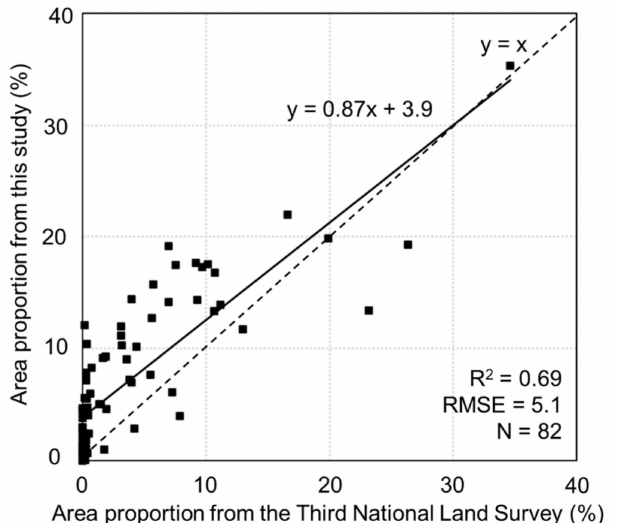
Figure 7. Comparison of bamboo area proportion (%) in this study and China’s Third National Land Survey. The linear fitted line and 1:1 line (y = x) are labelled in the figure by solid line and dashed line respectively. R 2 represents the correlation coefficient, and RMSE represents the root mean square error. N is the number of sample